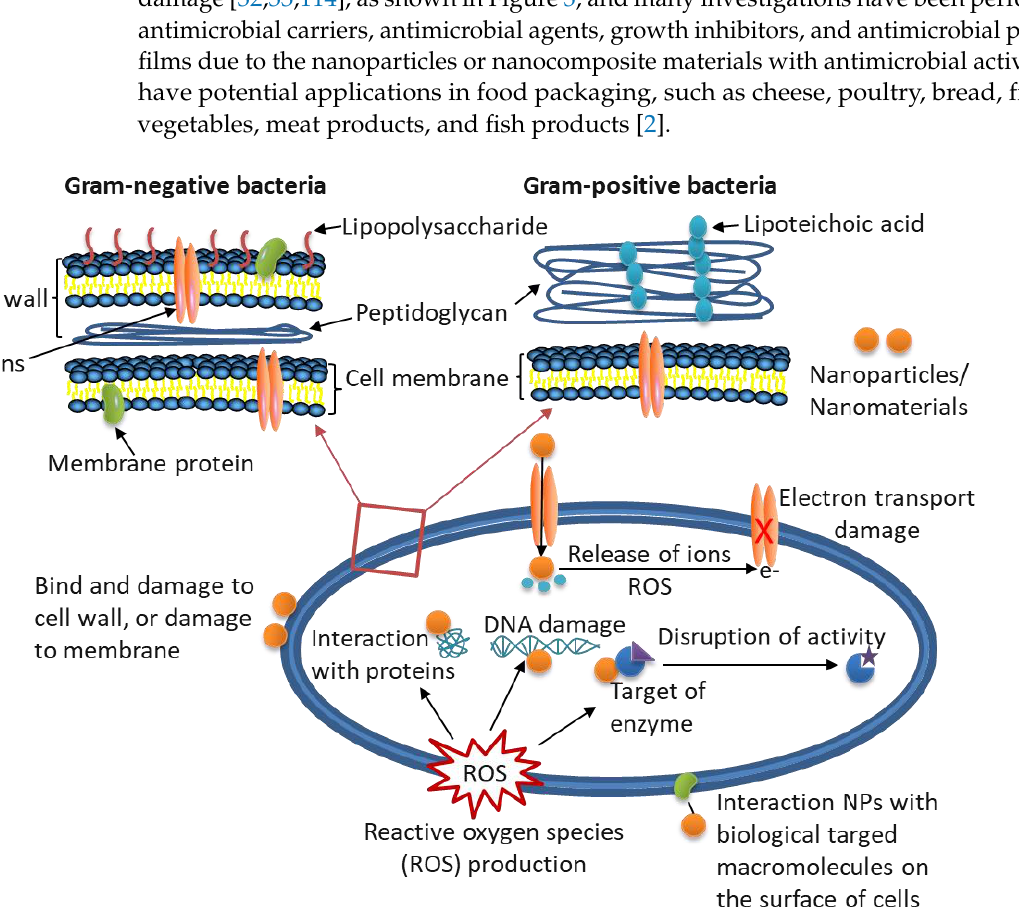
Figure 3. The potential antimicrobial mechanisms of nanoparticles/nanomaterials in food packaging (modified from Jamróz et al. [114]).